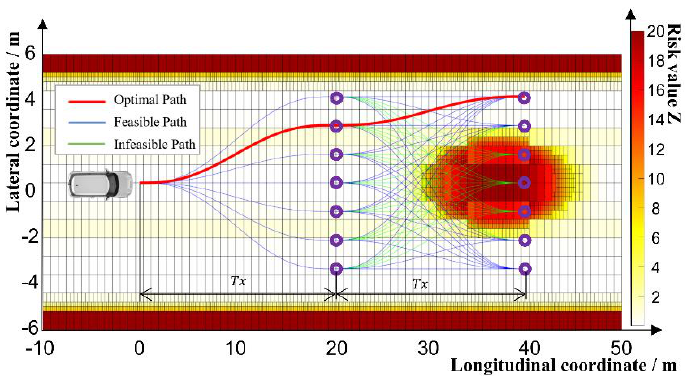
Figure 6. Path cluster generation.